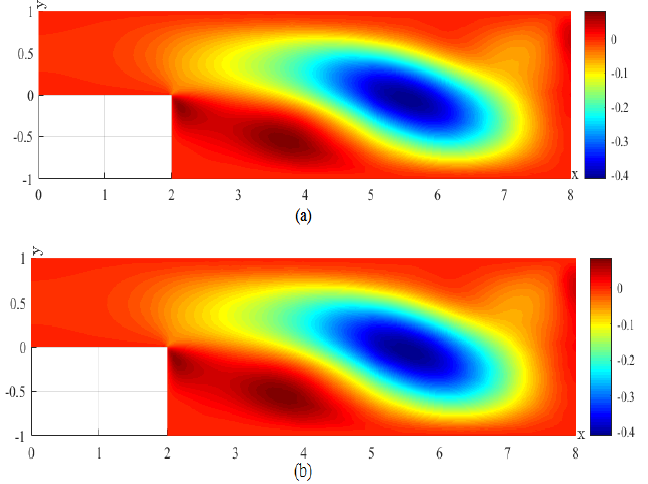
Figure 11. ( a ) The CNMFE solution for v at t = 8. ( b ) The RDRCNMFE solution for v at t =